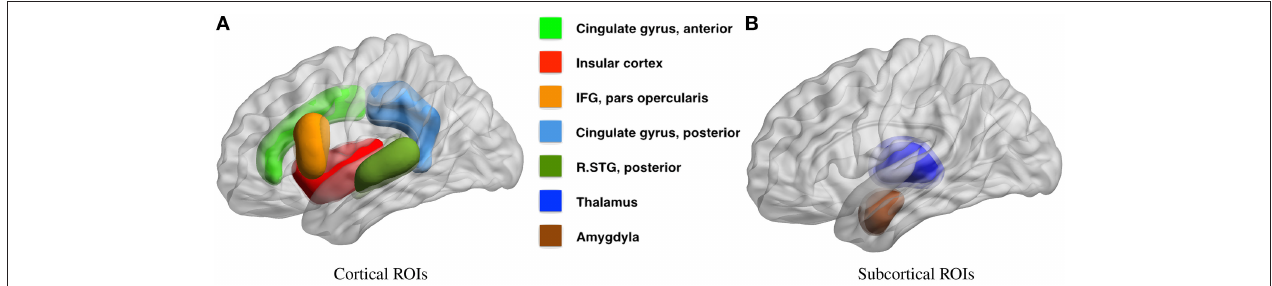
FIGURE 5 | Regions of interest for covariate tests of node density. This figure illustrates the regions of interest based on the Harvard Oxford Atlas that we have chosen to test for covariate effects in Table 2 . Several studies link the severity of autism spectrum disorders, measured by ADI or ADOS cognitive scores, with 9 cortical (A) and 4 sub-cortical (B) regions of interest, all within the default mode, limbic, frontoparietal, and ventral attention networks. The full literature review is available in Section 4.2.